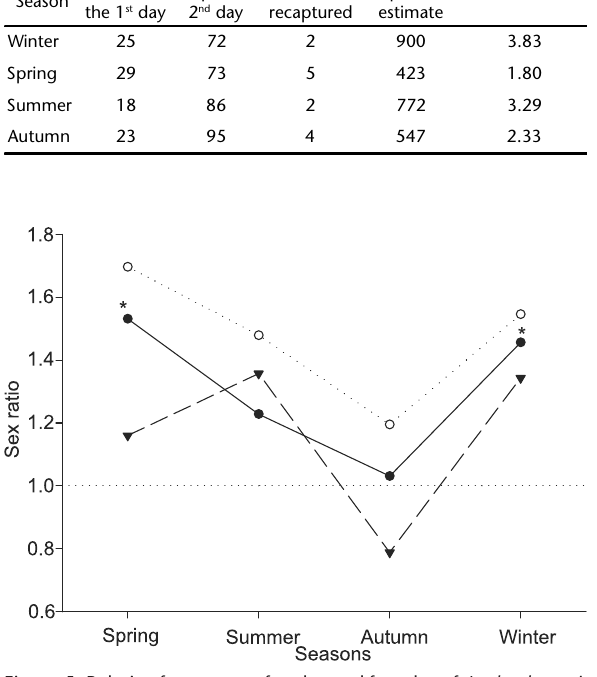
Figure 5. Relative frequency of males and females of Aegla platensis in the four seasons during the sampling period in the Lajeado Bonito stream, Uruguay Basin, Rio Grande do Sul state. Trap cap- tures, handnet captures, and global (traps + handnet captures) are plotted separately. The asterisk (*) denotes statistical differ- ence between the number of males and females by the Chi-square test (p < 0.05) for the global dataset. ( (cid:122) ) Global, ( (cid:123) ) hand net, ( (cid:84) ) trap.